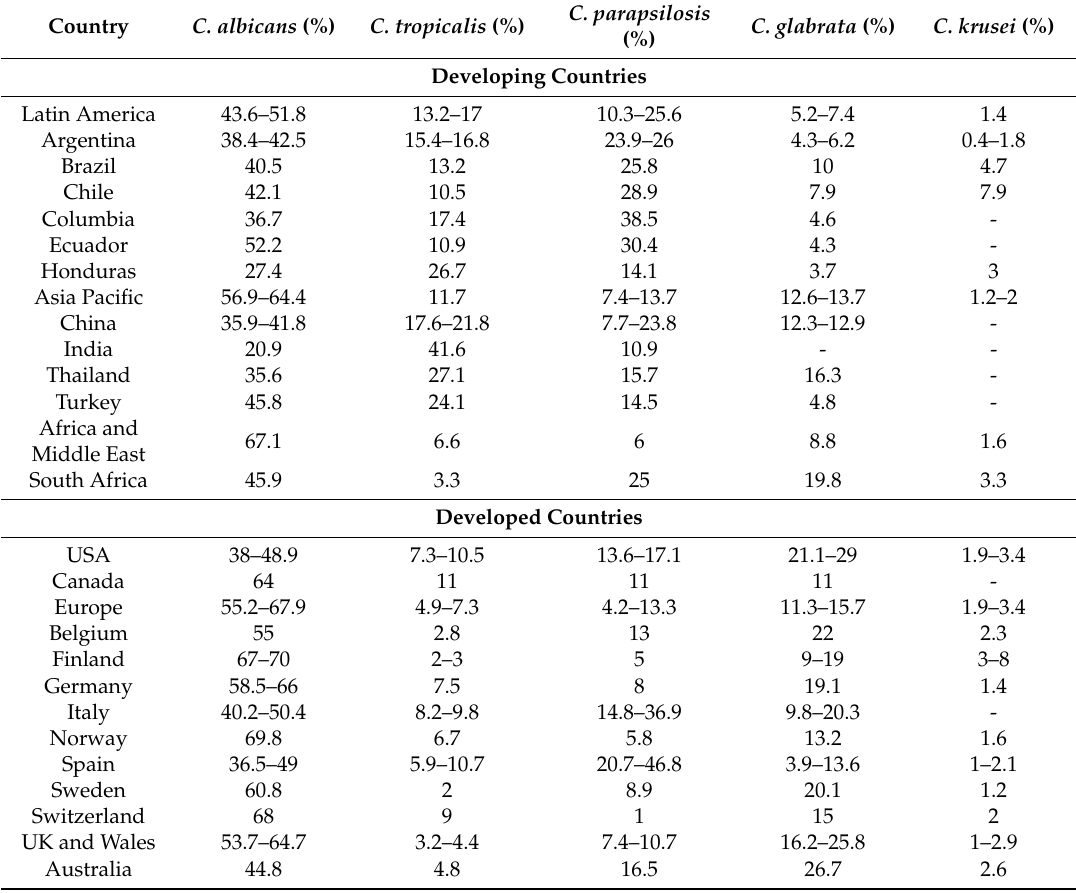
Table 3. Country-wise distribution of Candida species causing candidemia